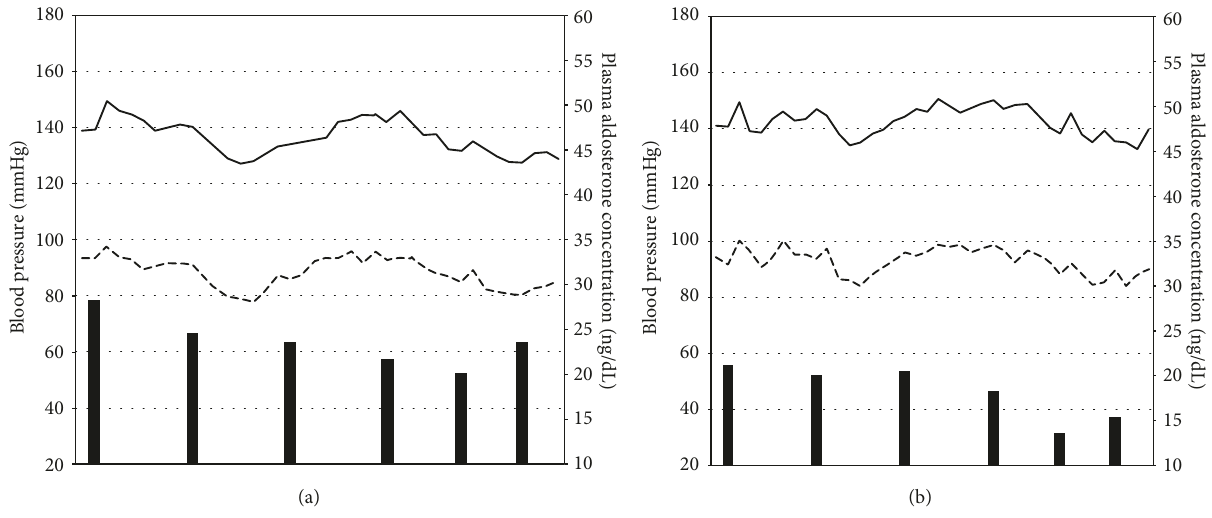
Figure 2: Circadian variation of blood pressure and plasma aldosterone concentration in patients with aldosterone-producing adenoma (a) and patients with essential hypertension (b). Note: the solid line represents systolic blood pressure, the dashed line represented diastolic blood pressure, and the bars represent plasma aldosterone